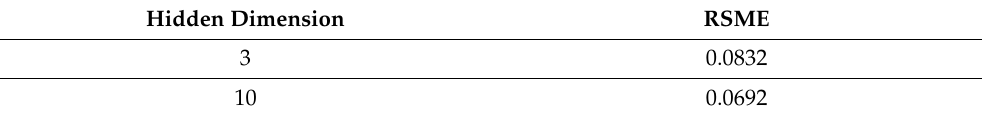
Table 18. Root mean squared error (RMSE) values based on the value of the hidden dimension.